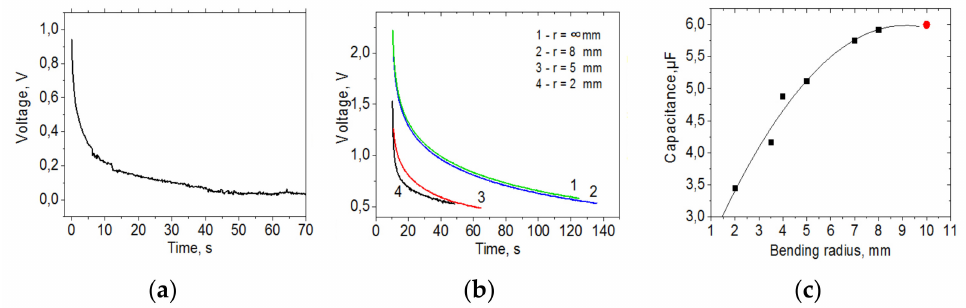
Figure 8. Time dependence of voltage: ( a )—for the structure from Figure 1b; ( b )—at different radius of deformation for the supercapacitor structure from Figure 1d; ( c )—Dependence of the capacitance of the supercapacitor structure on the bending radius. The red dot corresponds to the capacity of the structure before